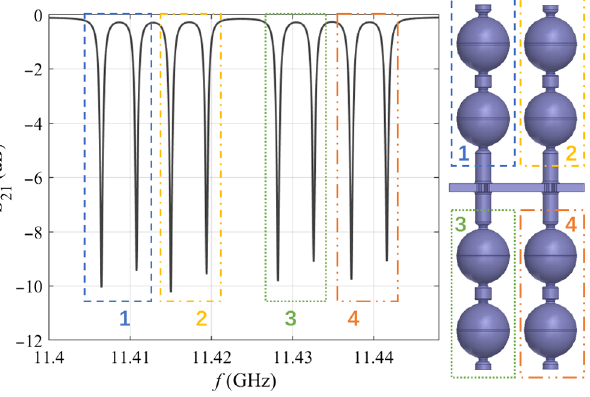
FIG. 5. Vacuum model and simulated transmission spectrum of CC. The dotted boxes show the correspondence between cavity pairs and resonant peaks. FIG. 4. Calculated power gains with different coupling factors and waveforms of one-stage and two-stage pulse compression. (a) Power gain of one-stage pulse compression versus coupling factor of the first storage cavity. (b) Input and output waveforms 4 . 0 in the case of the one-stage pulse compression with β s 1 ¼ with and without amplitude modification. (c) Power gain of the two-stage pulse compression versus coupling factor of the first and second storage cavities. (d) Input and output waveforms of 4 . 0 , β 30 . Red the two-stage pulse compression with β s 1 ¼ s 2 ¼ circles in (a) and (c) indicate the optimized coupling factor.